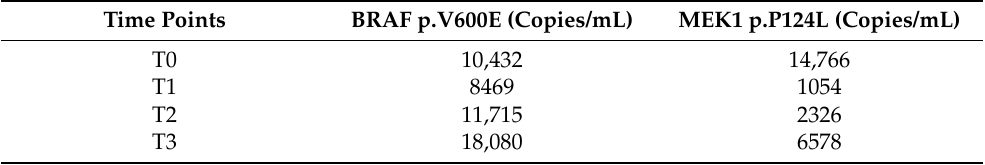
Table 3. BRAF pV600E and MEK1 p.P124L ctDNA amount (copies/ml plasma) in samples longitudi- nally